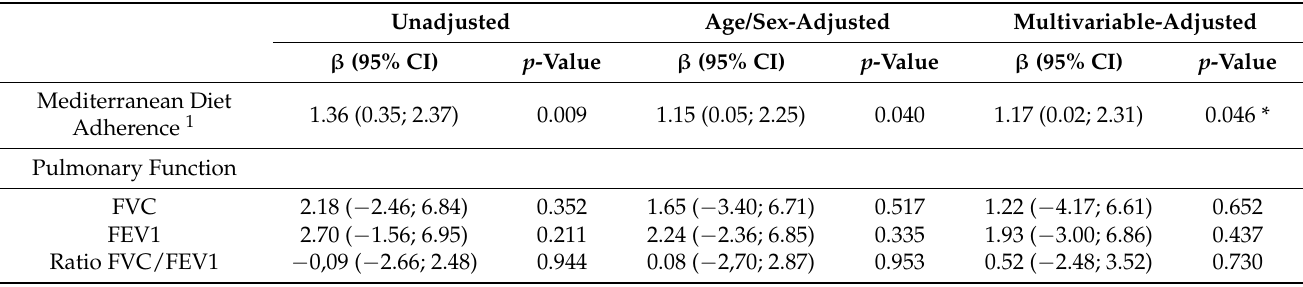
Table 3. Relationship between adherence to Mediterranean diet and pulmonary function variables to randomized assign- ment group (unadjusted, age/sex-adjusted and multivariable-adjusted β -coefficients and 95%